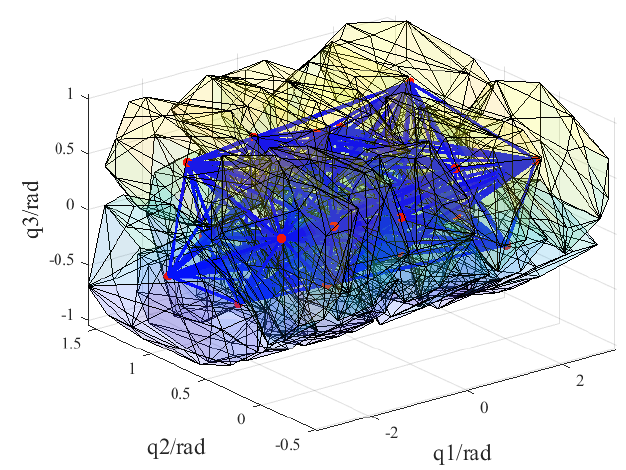
Figure 10. The HCN of the 3-DOF manipulator.